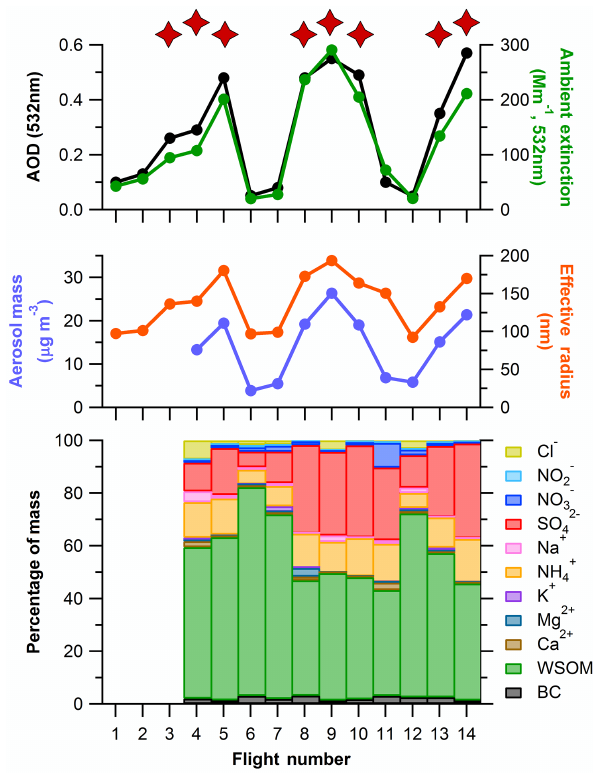
Figure 4. Average AOD (at ambient RH) along with boundary layer (below 1km) extinction, aerosol mass, effective radius, and compo- sition for each of the 14 flights. Aerosol mass and composition data are not available for the first three flights. Flights with predomi- nantly westerly transport from the Ohio River Valley are indicated by stars at the top of the